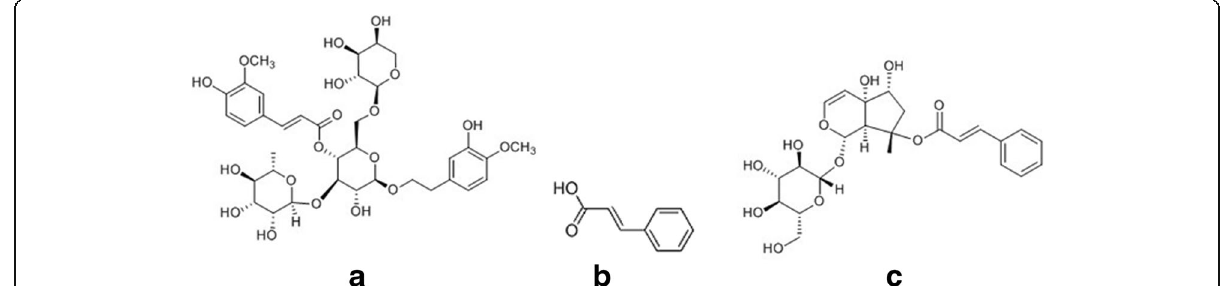
Fig. 1 Chemical structures of ( a ) angoroside C, ( b ) cinnamic acid and ( c ) harpagoside